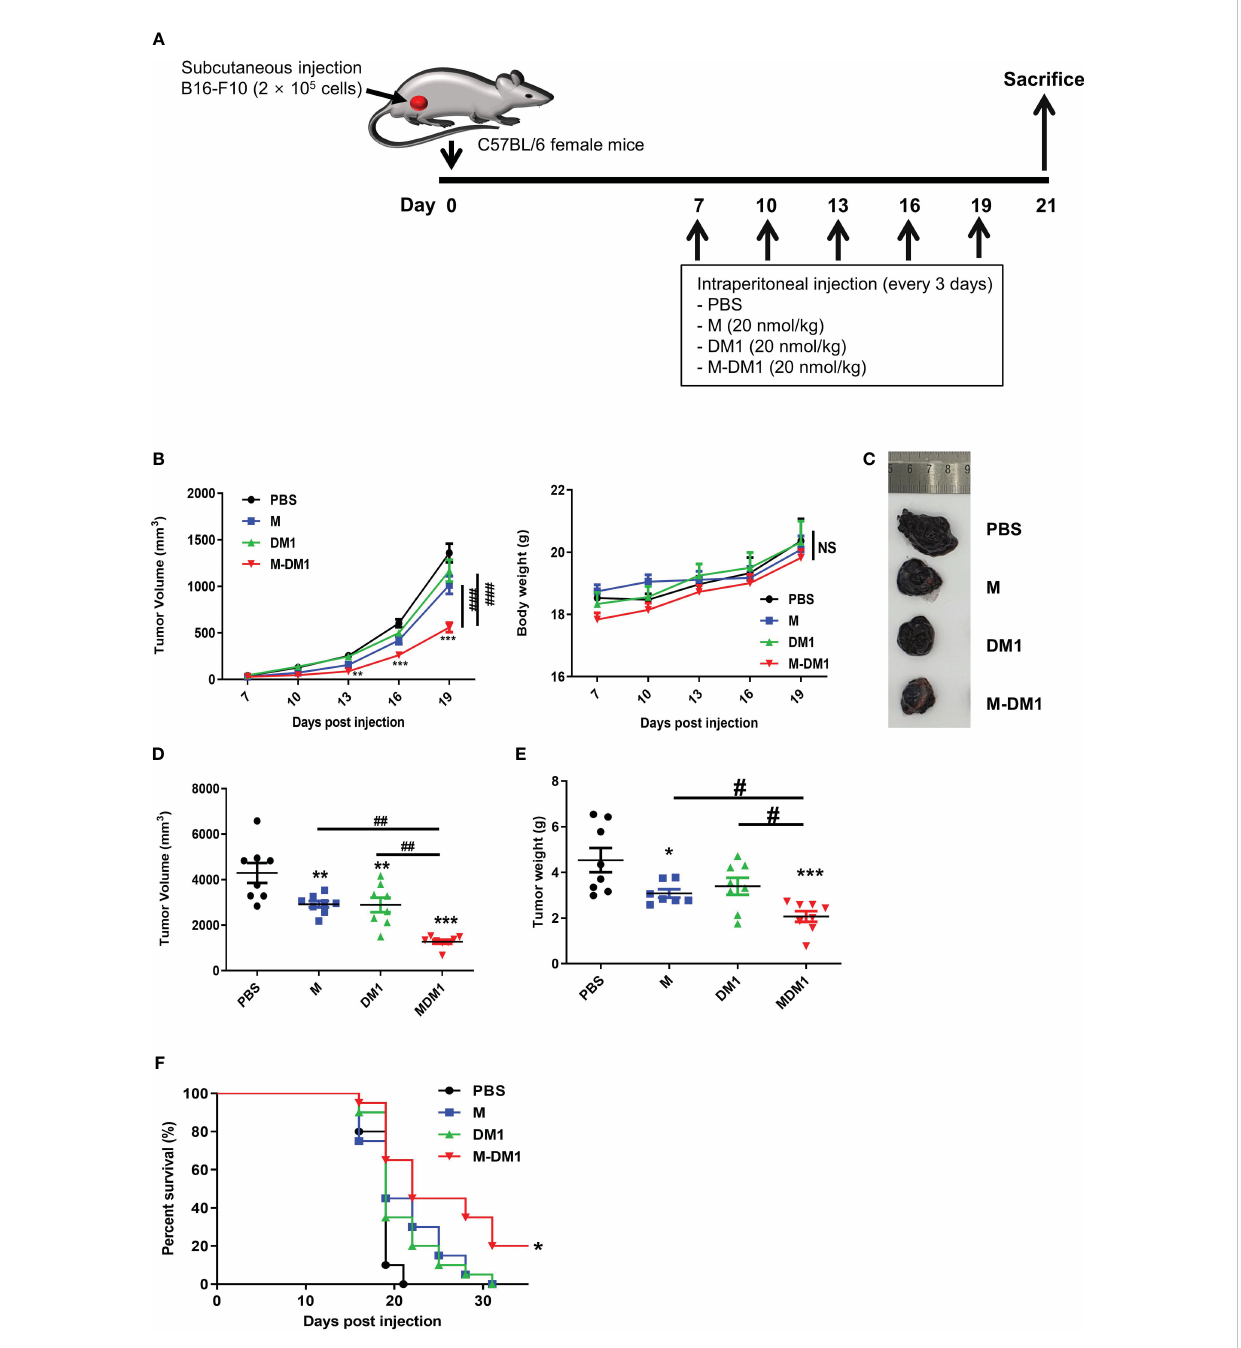
FIGURE 4 The anti-tumor effects of M-DM1 in a mouse model of melanoma. (A) Schematic representation of the experiment. B16F10 mouse melanoma cells were inoculated into the right fl ank of mice. Seven days after inoculation, each drug was intraperitoneally injected once every 3 days. (B) Tumor size and body weight were measured using a digital caliper and an electronic scale, respectively ( n = 8 mice). The tumor volume was calculated using the following formula: V = (width (2) × length)/2. The data are presented as the mean ± SD. Two-way ANOVA followed by Bonferroni post-hoc test was performed for group comparisons; **p < 0.01, ***p < 0.001 vs PBS group; ###p < 0.001 vs M or DM1 group; NS, no signi fi cance. To assess tumor volume and weight, the mice were sacri fi ced on day 21 after tumor inoculation. (C) Tumor tissues were imaged, and (D) tumor volume and (E) weight were measured using a digital caliper and an electronic scale, respectively, after sacri fi ce ( n = 8 mice). All data are presented as the mean ± SD. One-way ANOVA followed by Tukey ’ s post-hoc test was performed for group comparisons; *p < 0.05, **p < 0.01, ***p < 0.001 vs PBS group; #p < 0.05, ##p < 0.01 vs M or DM1 group. (F) The survival rate following the treatment of the mice with each drug was evaluated by Kaplan-Meier survival analysis in the mouse melanoma model. The median survival and p-values were determined using the log-rank test (Mantel-Cox).